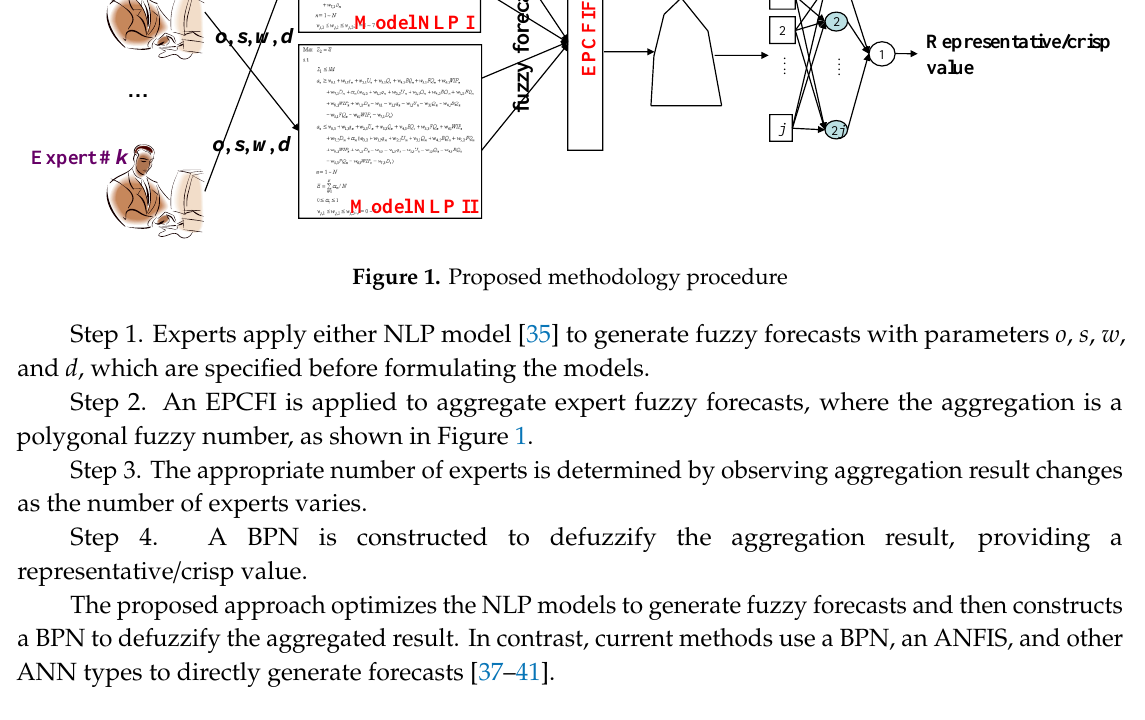
Figure 2. Fuzzy intersection (consensus). When an overall consensus among experts cannot be achieved, the FI is the null set. In this situation, a consensus among some experts can be sought instead by using the PCFI operator [19].